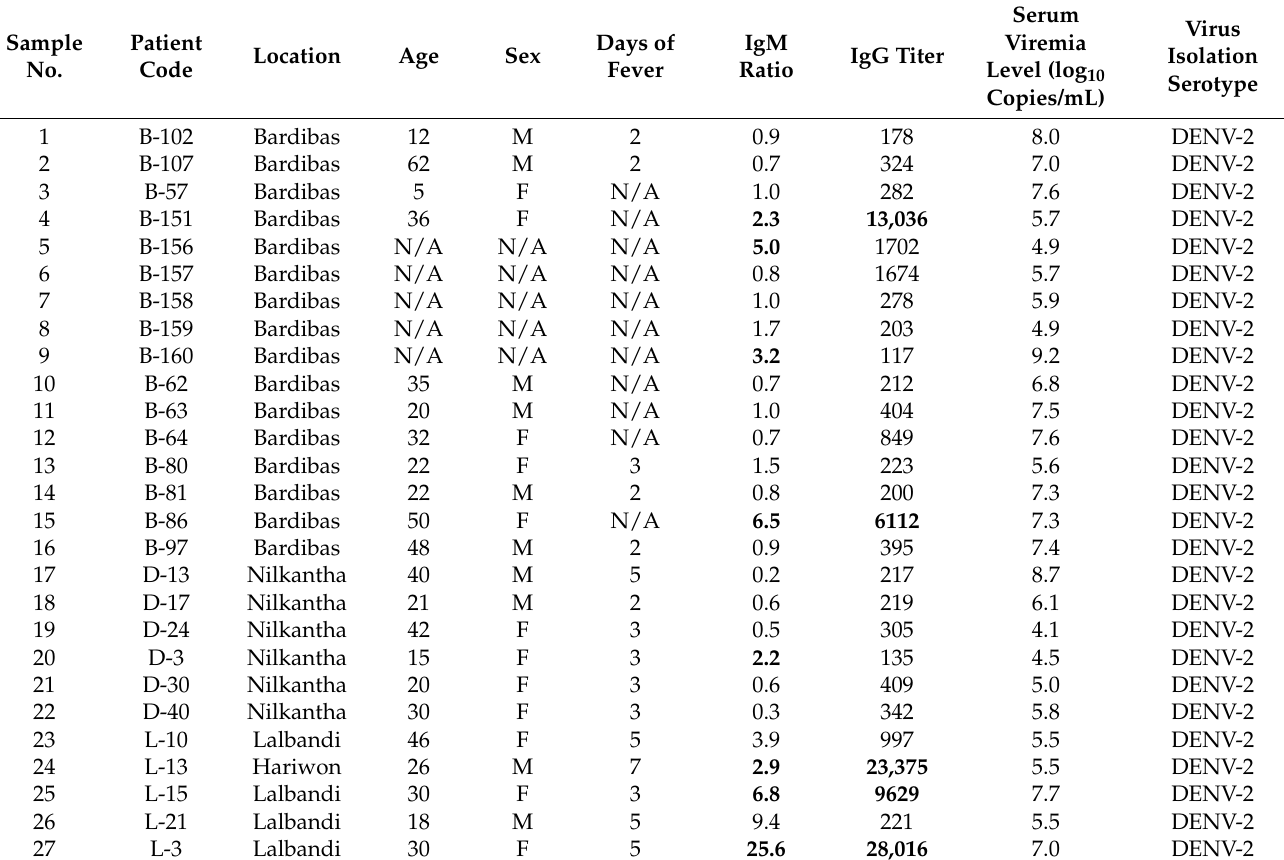
Table 1. Demographic and laboratory profiles of dengue suspected patients with positive DENV isolation results ( n = 27).